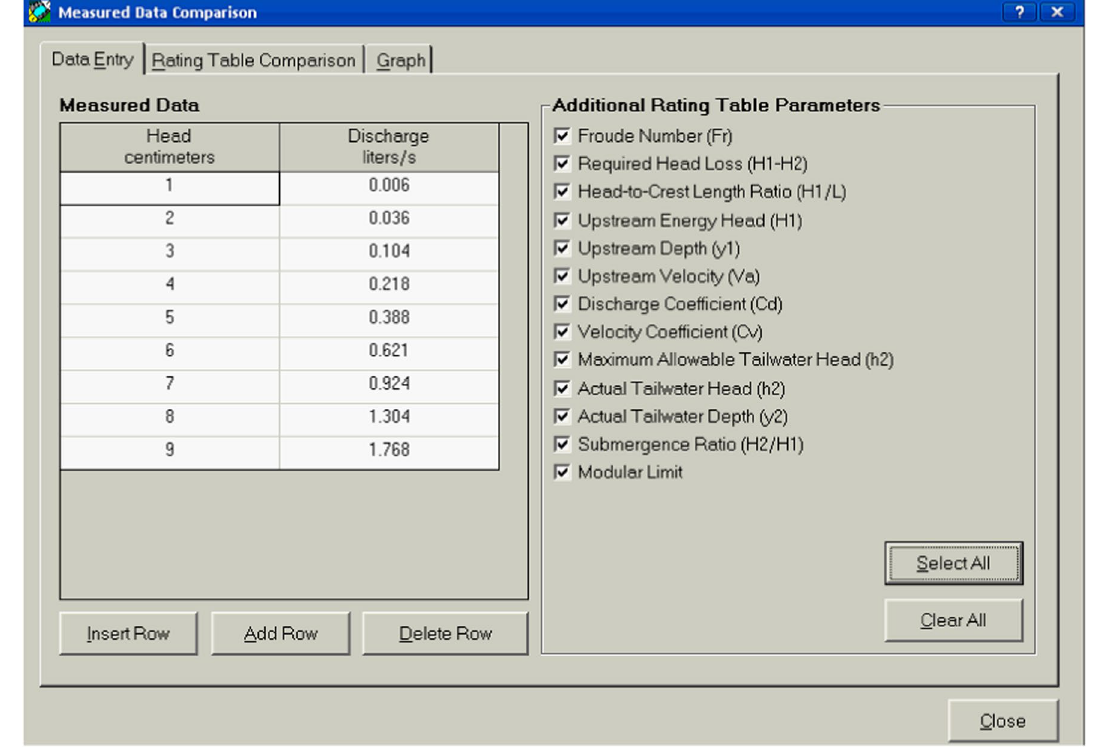
Fig. 8 Enter the obtained flow according to the flow-Ashle formula for different heights on the Eschlum (Gage)